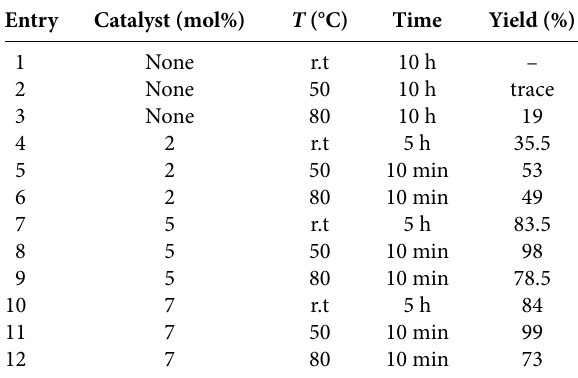
Table 1. Optimization of reaction conditions for preparing 1,3,5-triphenylimidazole